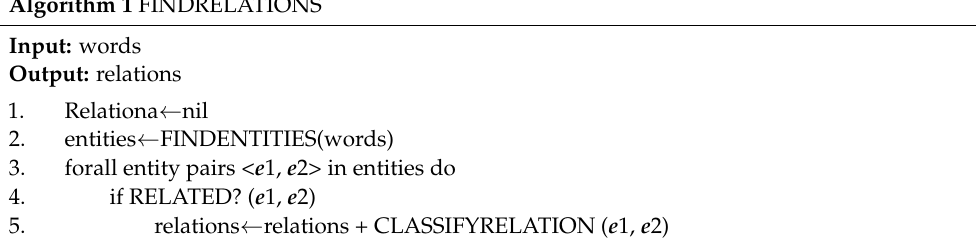
Algorithm 1 FINDRELATIONS